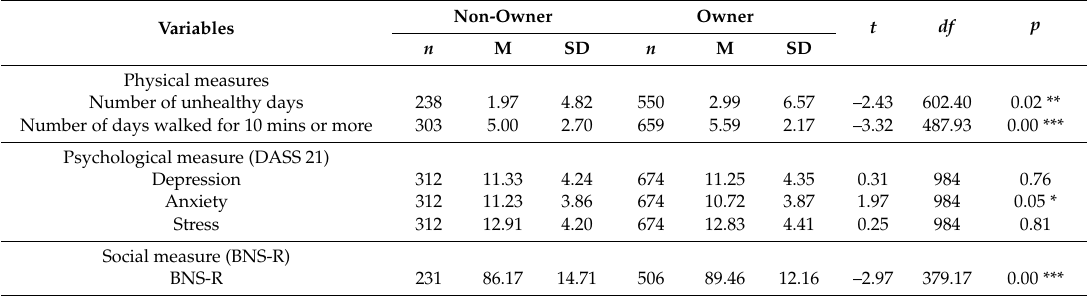
Table 2. Descriptive statistics and independent t -test results on the physical and psychosocial measures by ownership